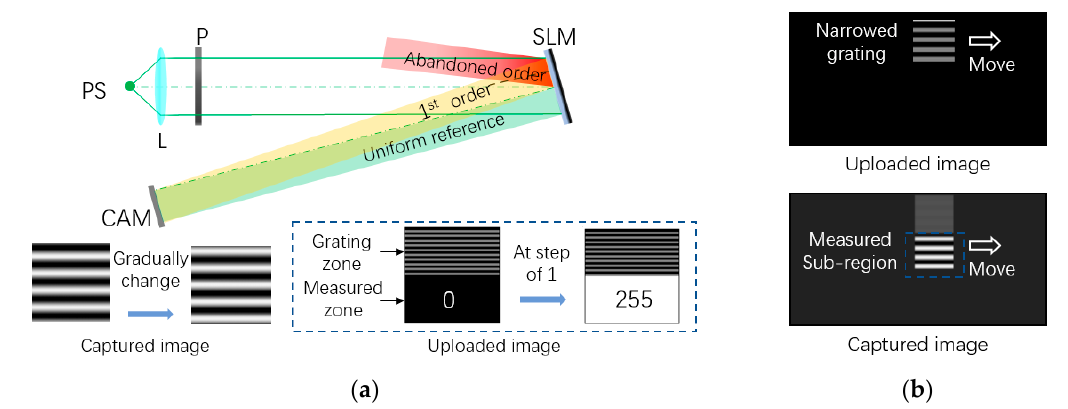
Figure 4. ( a ) Configuration of the self-referenced phase calibration method able to measure spatial nonuniformity. PS: monochromatic point light source; L: collimating lens; P: polarizer; SLM: spatial light modulator; CAM: camera. ( b ) Grayscale pattern uploaded on the SLM for the nonuniformity measurement and image captured by the camera [21] .